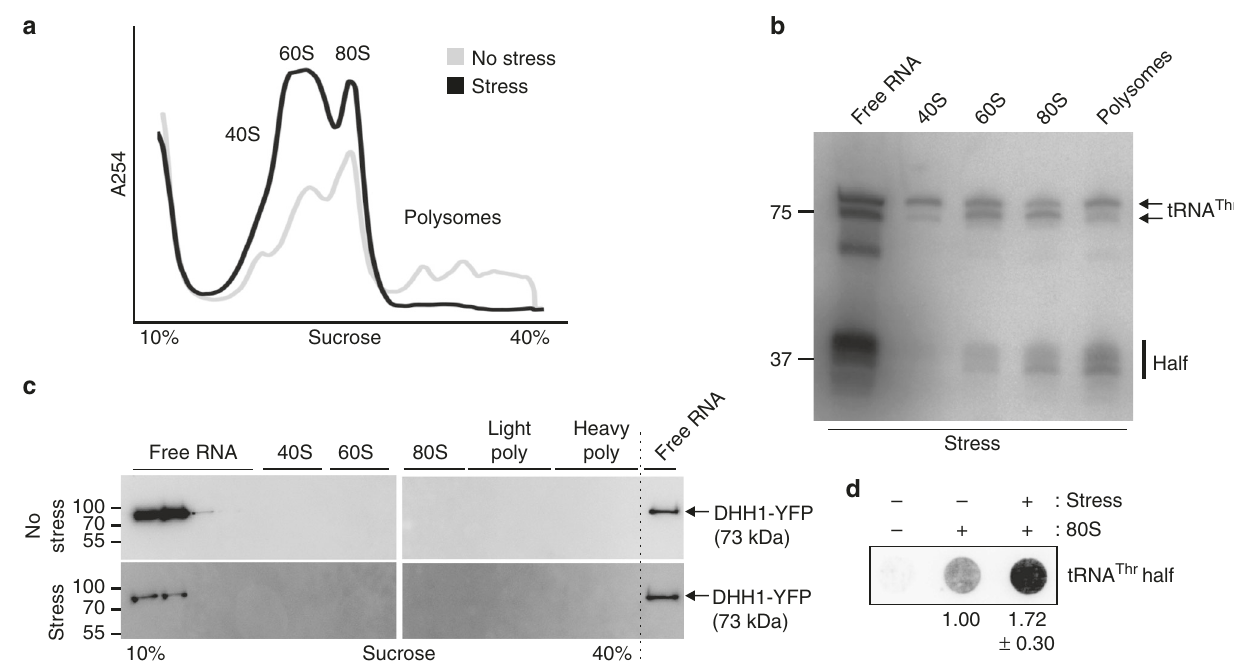
Fig. 4 The tRNA Thr 3 ′ half associates with ribosomes in vivo and in vitro. a Polysome pro fi ling with sucrose gradients (10 – 40%) using total cell lysates prepared from exponentially growing T. brucei cells (gray) and from cells starved for 2 h in PBS (black). b RNA was extracted from fractions containing polysomes, 80S monosomes, 60S, or 40S ribosomal subunits and from the light sucrose gradient fractions (free RNA) and used for northern blot analysis to monitor the tRNA Thr 3 ′ half (length: 37 nucleotides). In a and b representative data of three independent experiments are shown. c Fractions from the polysome pro fi les of unstressed (no stress) or starved (stress) cells were also investigated for the presence of the YFP-tagged DHH1 (73 kDa) by western blot analysis. The location of molecular weight protein markers are indicated (see also Supplementary Figure 16). Western blots have been repeated twice. d Association of the tRNA Thr 3 ′ half to ribosomes was analyzed employing in vitro fi lter binding assay using gradient-puri fi ed 80S ribosomes isolated from starvation stressed or unstressed cells and 5 ′ [ 32 P]-end labeled synthetic tRNA halves. The mean and standard deviation of four independent binding experiments are shown underneath the scan, whereas binding ef fi ciency employing unstressed 80S ribosomes was set to